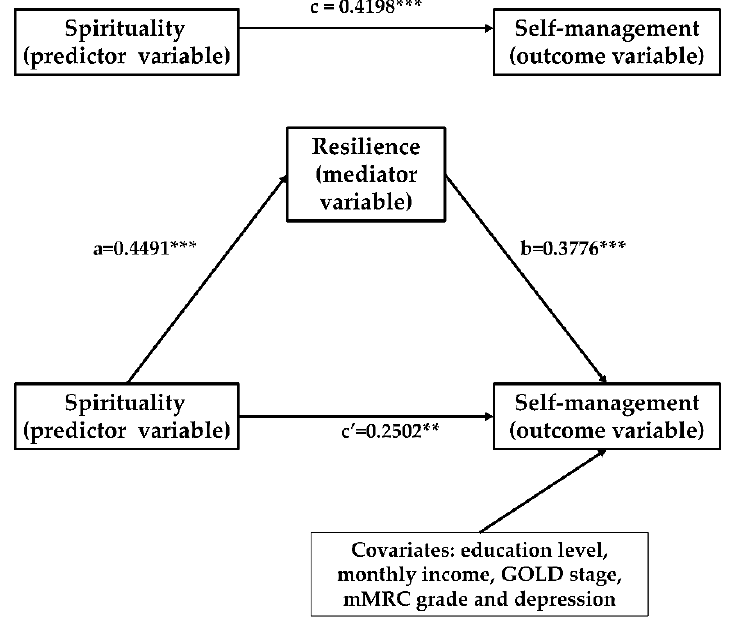
Figure 2. Proposed models that investigate mediated effects (** p < 0.01; *** p < 0.001).